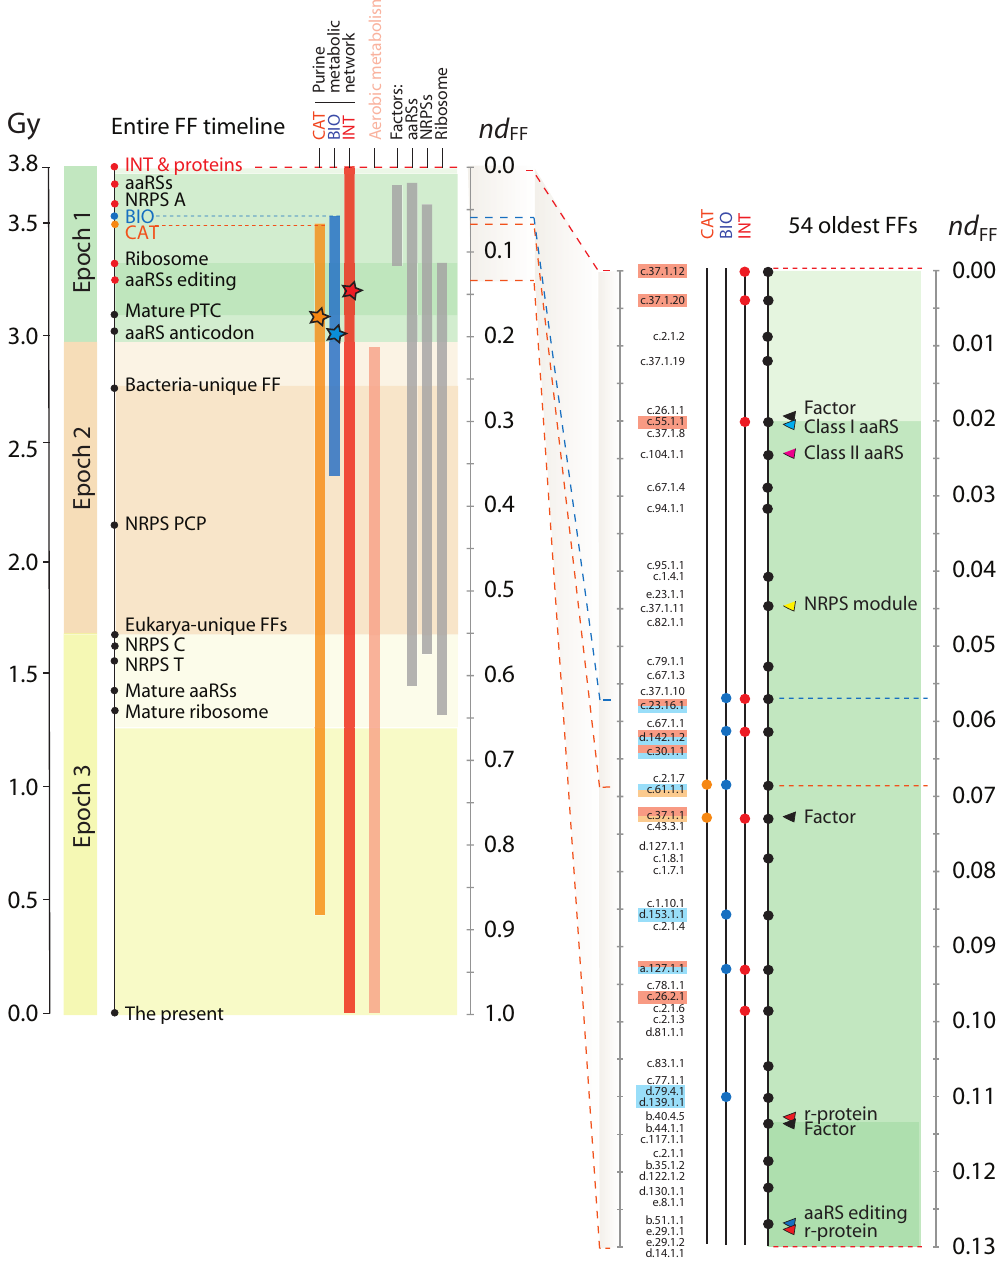
Figure 3. Timeline describing the evolution of FF domain structures and the evolution of main pathways of purine metabolism. The timeline was derived directly from the tree of FFs reconstructed from free-living organisms. Ages are given as node distances ( nd FF ) and geological time (Gy). Time flows from top to bottom. The three evolutionary epochs of the protein world defined by Wang et al. [8], ‘‘architectural diversification’’ (epoch 1), ‘‘superkingdom specification’’ (epoch 2), and ‘‘organismal diversification’’ (epoch 3) are overlapped to the timeline (colored with different shades). Landmark discoveries [18,19] are identified with circles along the timeline. The inset below describes the evolution of the 54 most ancient FFs. Stars represent the fulfillment of a full repertoire of enzymes in a central pathway. ancient enzymatic domain of the BIO pathway, the class I We used the molecular clock of FSF domains to assign approximate geological ages to the origin of purine metabolic pathways, since the FFs of the most ancient enzymes were the most ancient in the corresponding FSFs. The nucleotide (energy) interconversion of the INT pathways appeared at the start of the protein world embodied in the ATPase domain-like FF (c.37.1.12) of ABC transporters, , 3.8 Gy ago (Figure 3). In turn, the most